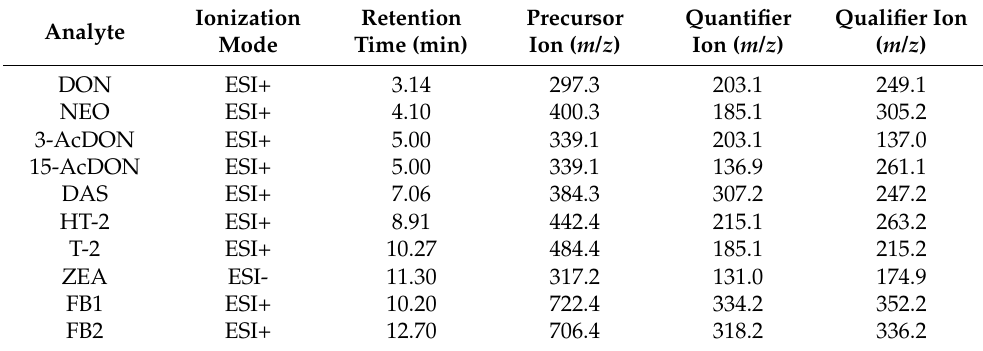
Table 7. Retention times of Fusarium toxins, ionization mode and monitored